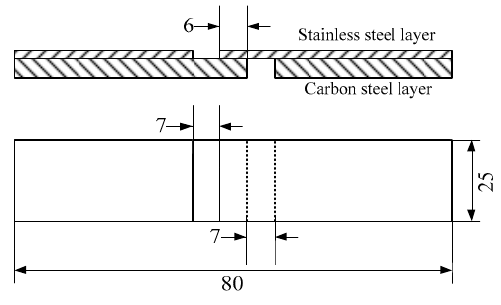
Figure 2. Schematic of shear test specimens (in mm).